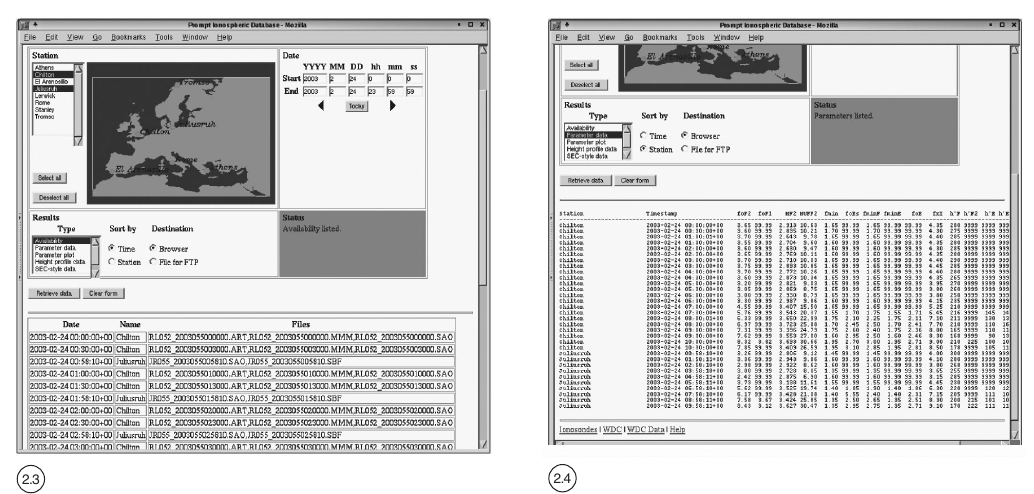
Fig. 2.3. Displaying availability of data files in the Prompt Ionospheric Soundings Database. Fig. 2.4. Listing auto-scaled parameters in the Prompt Ionospheric Soundings